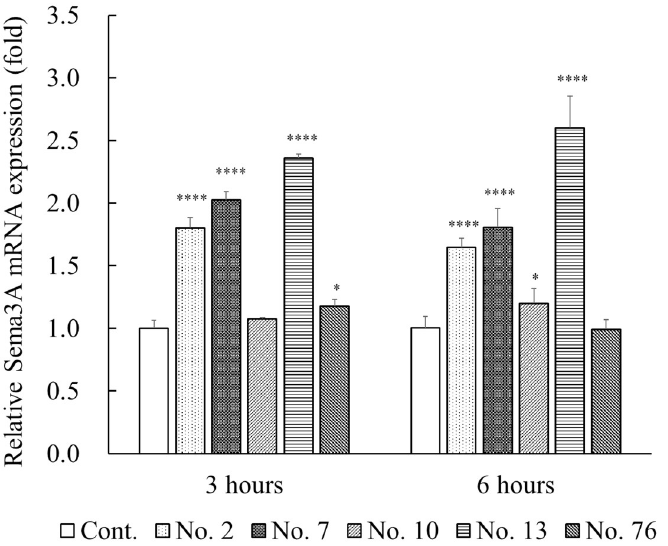
Fig 2. Effects of five positive plant extracts on the expression of Sema3A mRNA in cultured NHEKs. NHEKs were incubated with five plant extracts, samples No. 2, 7, 10, 13, and 76 at a final concentration of 50 μ g/mL for 3 and 6 hours at 37˚C. Expression of Sema3A mRNA was examined using quantitative real-time PCR analysis. The levels of Sema3A mRNA were normalized relative to those of RPS18 . All results are expressed as mean ± S.D. of three independent experiments. � p < 0.05, �� p < 0.01, ��� p < 0.001, ���� p < 0.0001 (one-way ANOVA followed by Dunnett’s